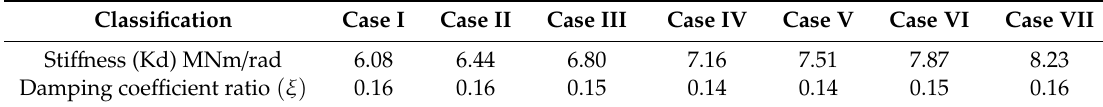
Table 3. Case study with varied sti ff ness and damping coe ffi cient ratio based on optimum damper